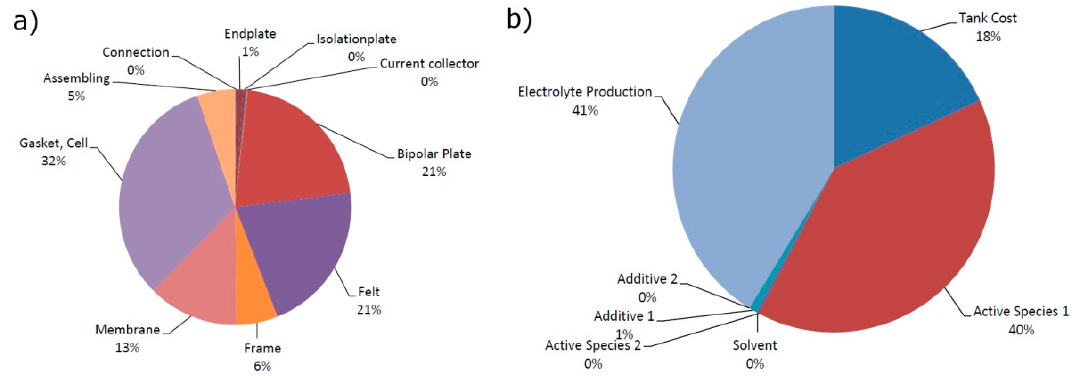
Figure 4. Breakdown of the stack costs ( a ) and energy costs ( b ) of a 10 kW/120 kWh VRFB.